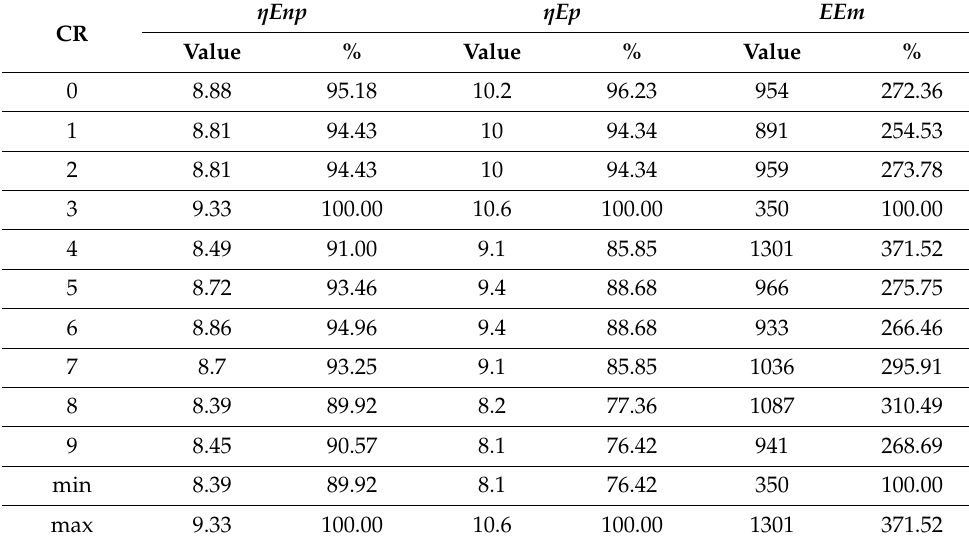
Table A10. Average emissions and efficiency of crops according to the climatic regions.